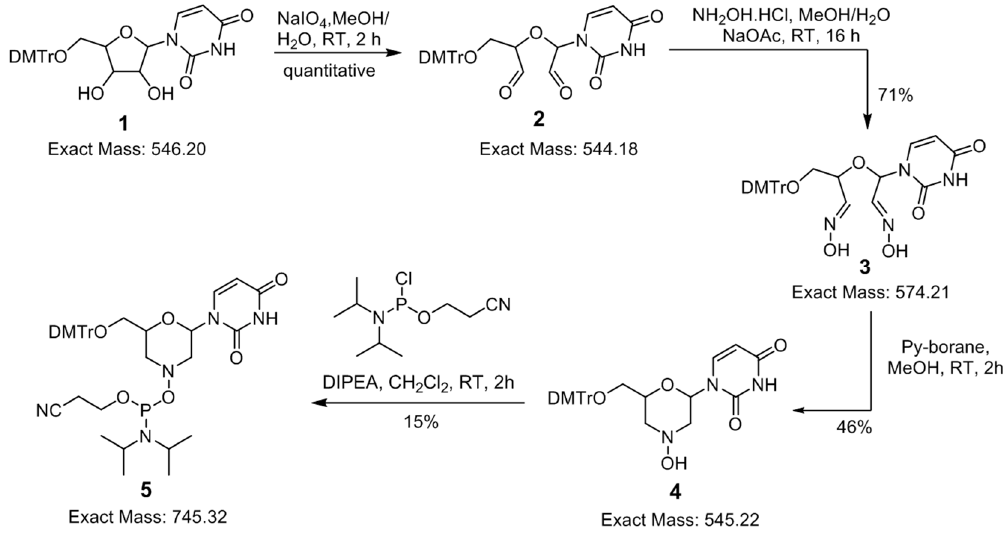
Figure 2. Synthesis of MNA-uridine phosphoramidite.